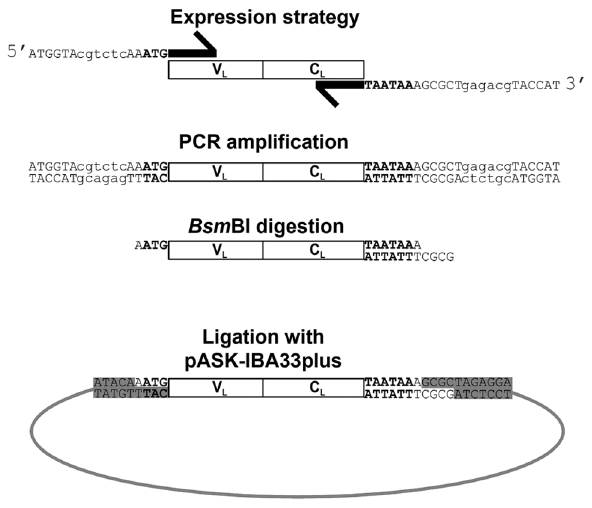
Figure 1. Schematic representation of the expression strategy. Each patient’s full-length monoclonal LC (V L + C L ) obtained by RT-PCR was re-amplified using primers designed according to the pASK-IBA cloning strategy. Start Met codon in 5 9 primer and the two stop codons in 3 9 primer were introduced and shown in bold, Bsm BI recognition sites are indicated in lower case in both primers. After Bsm BI digestion, PCR product was ligated into Bsa I/ Bsa I sites of pASK-IBA33plus vector.